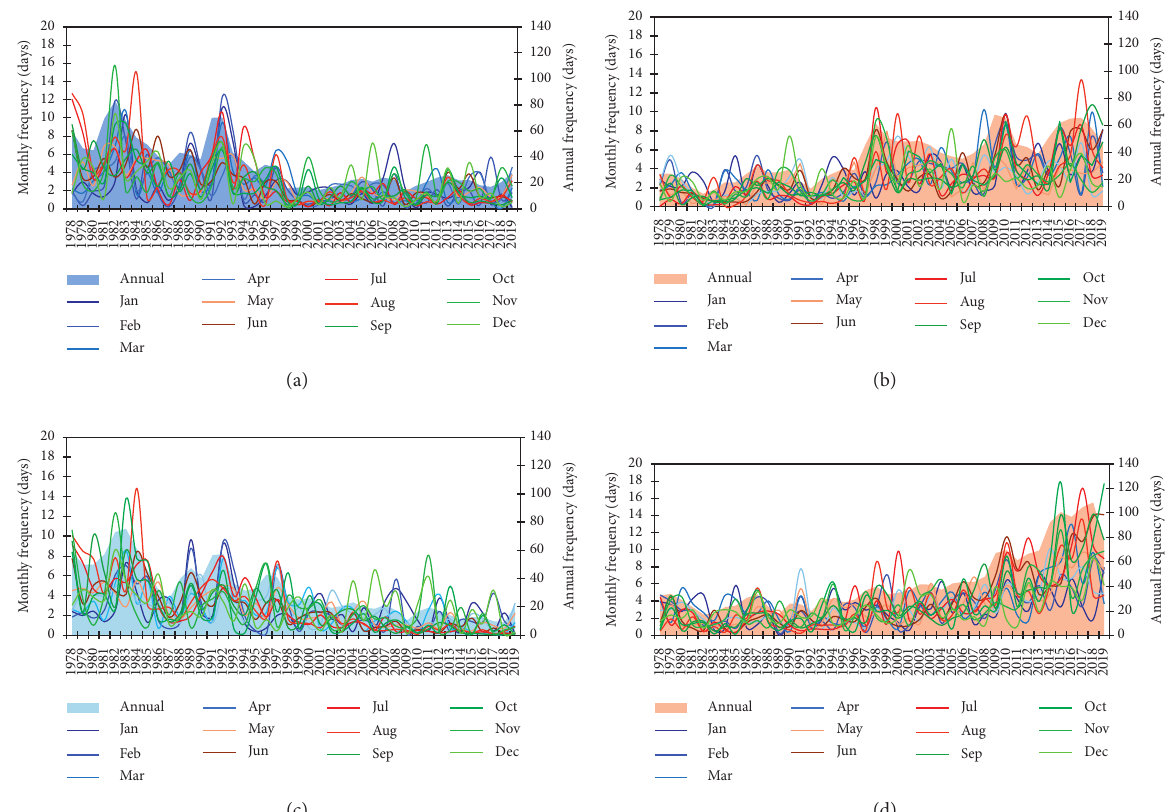
The superscripts a, b, and c represent statistical significance at 99%, 95%, and 90% confidence level, respectively.